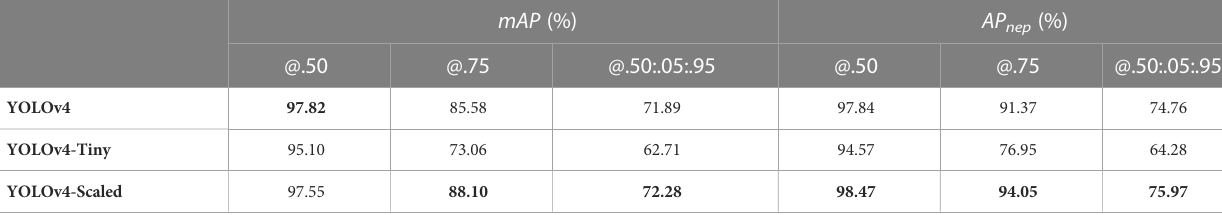
TABLE 4 Performance comparison of the detector models.